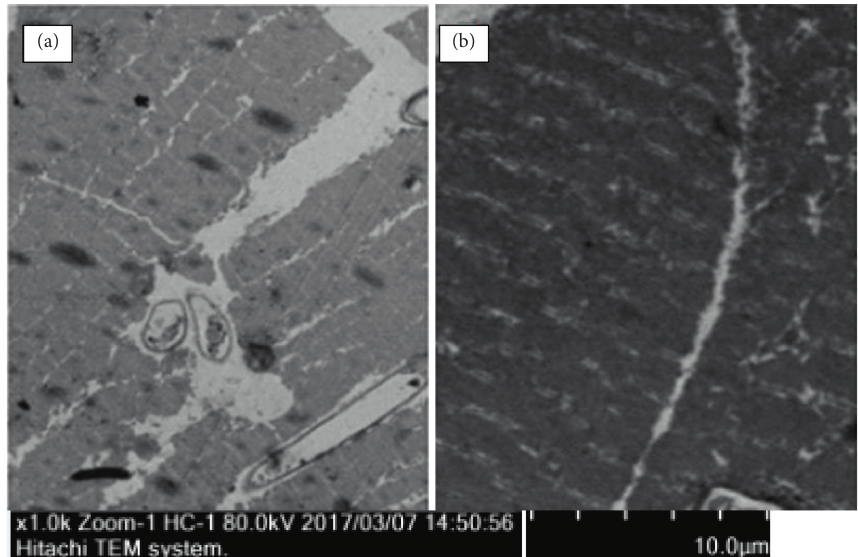
Figure 3: Microstructures of chicken meat fermented with P. nalgiovense (a) and P. chrysogenum (b) observed with TEM. Samples from ten pieces of chicken meat for each treatment were examined.